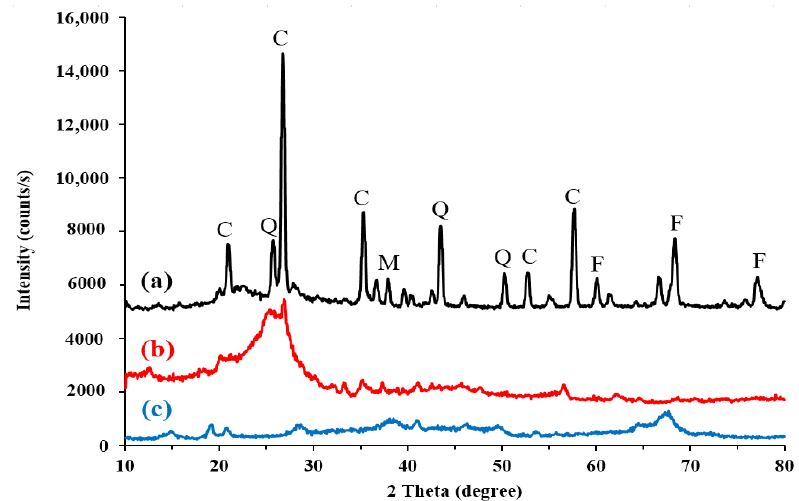
Figure 1. XRD analysis of natural zeolite (a), activated carbon (b), and activated alumina (c). Q: quartz; M: mordenite; C: clinoptilolite; F: feldspar.